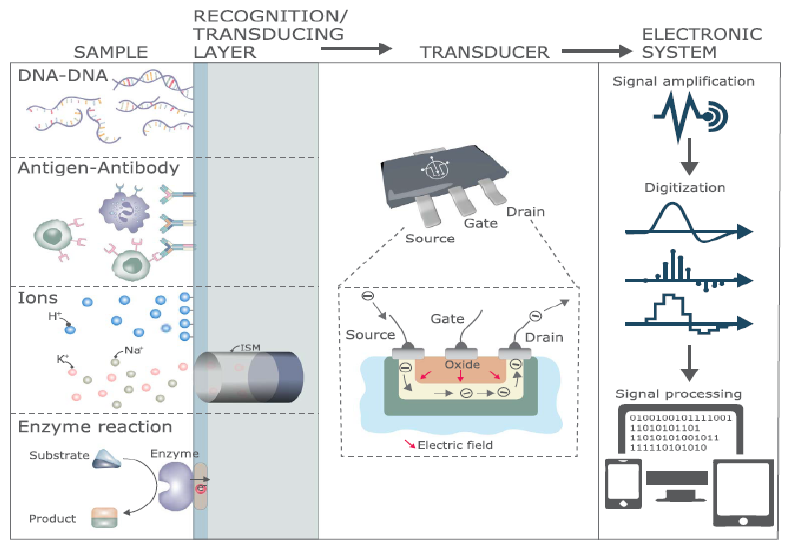
Figure 6. Depiction of a chemical and biological FET sensor. Reprinted with permission from Ref. [113]. Copyright 2017, Elsevier.